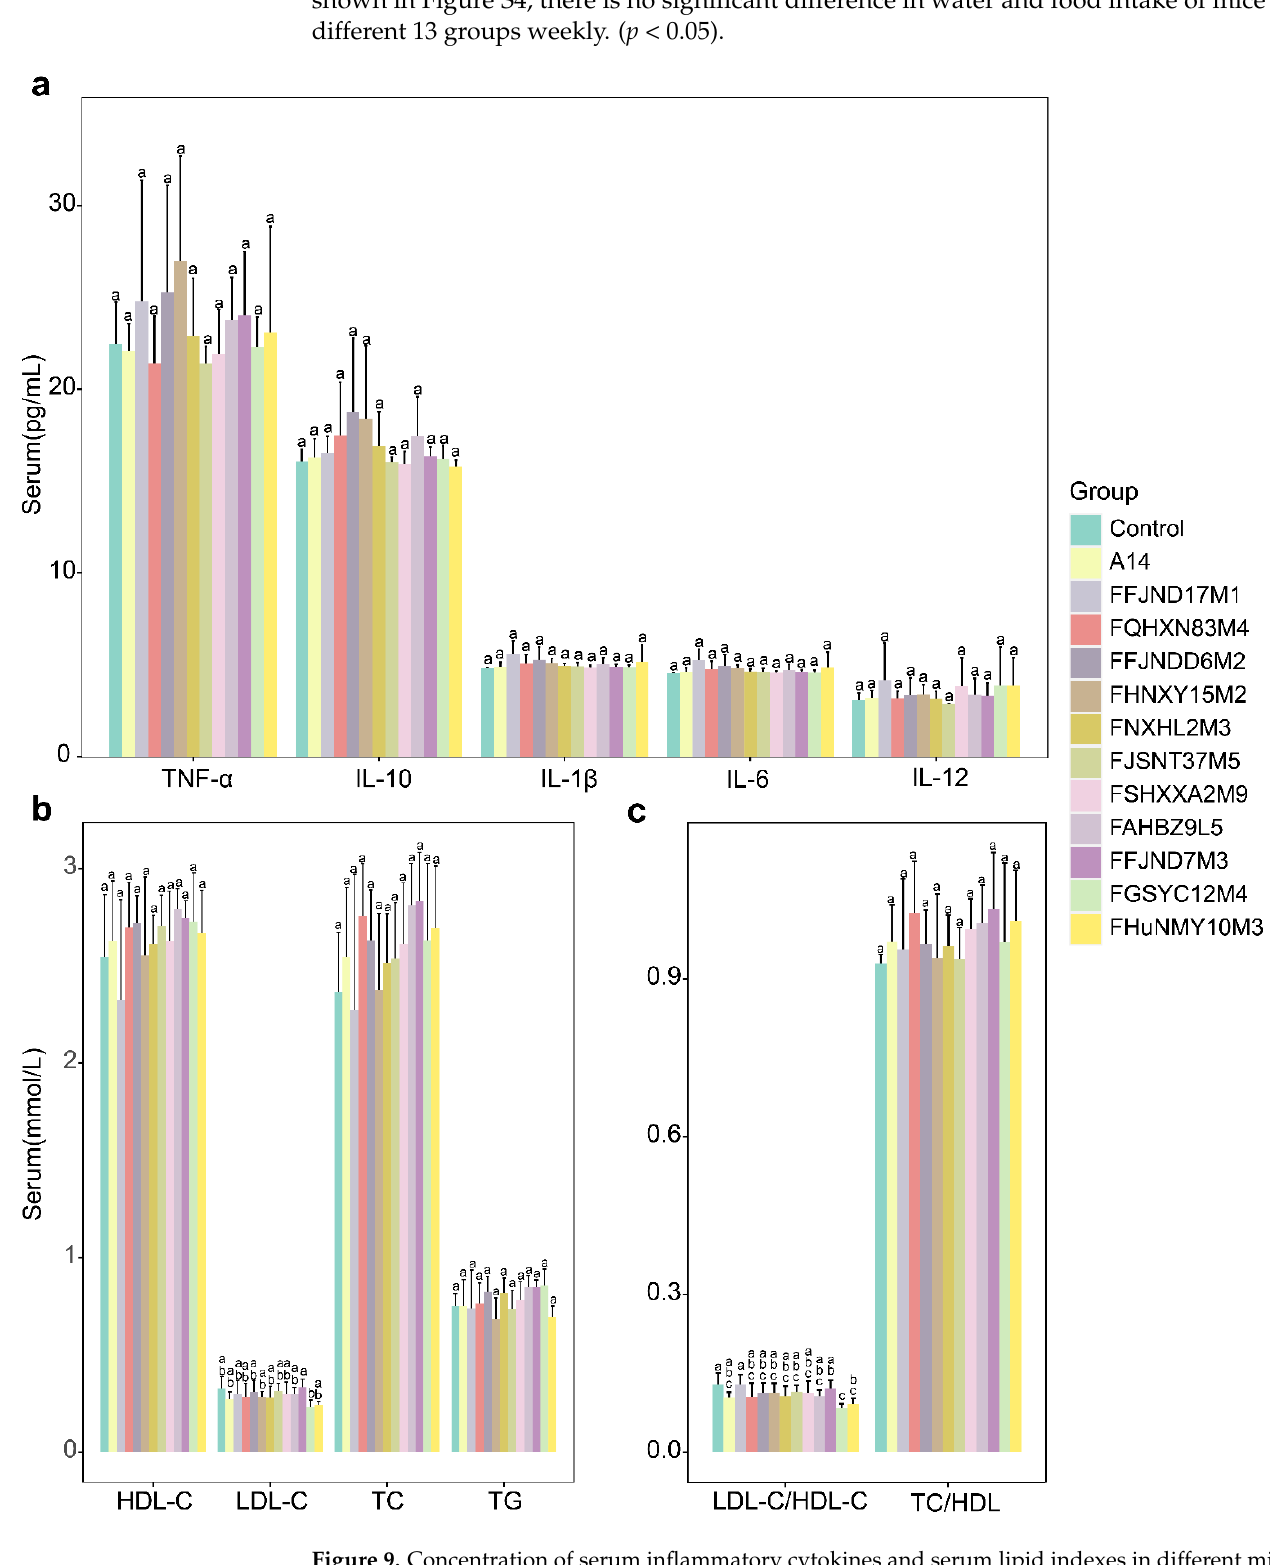
Figure 9. Concentration of serum inflammatory cytokines and serum lipid indexes in different mice groups ( a – c ). Different lowercase letters mean that there is a statistically significant difference between 13 groups at a probability level of p < 0.05.